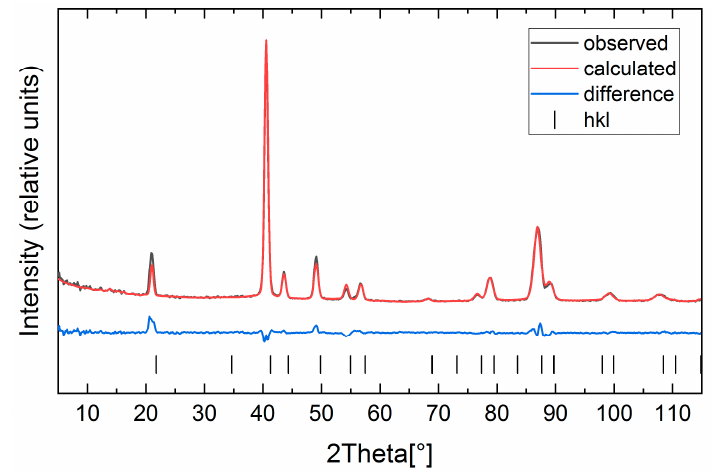
Figure 5. Magnetic refinement of the neutron powder diffractogram of Mn 1.8 Co 0.2 Sb at RT (Shubnikov group: Pmm’n’ ).